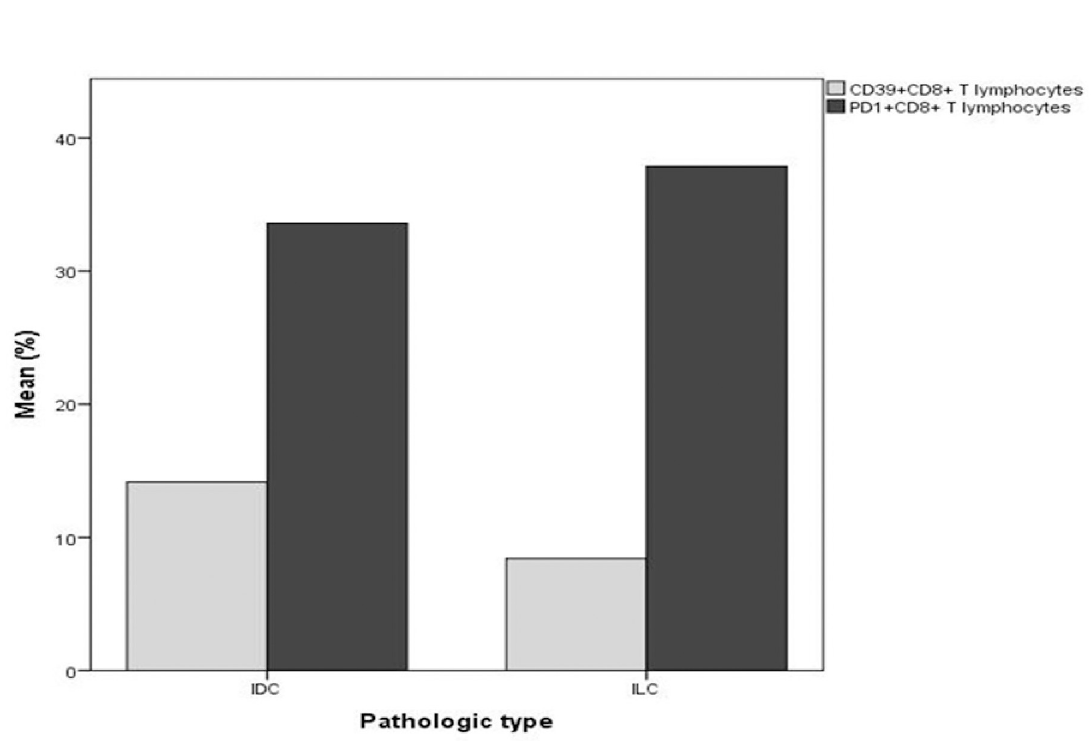
Fig 6. Significant differences in the mean percentages of PD1 + CD8 + ( p = 0.03) and CD39 + CD8 + peripheral T lymphocytes ( p = 0.04) according to pathologic type (ILC, and IDC respectively), in 30 patients with TNBC (Independent t-test).